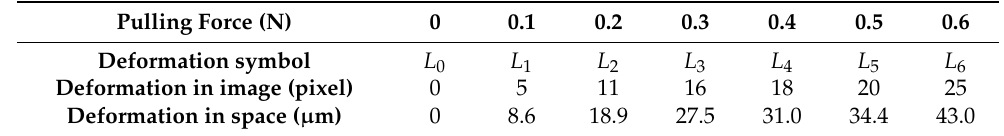
Table 7. Results of deformation measurement via different pulling force.